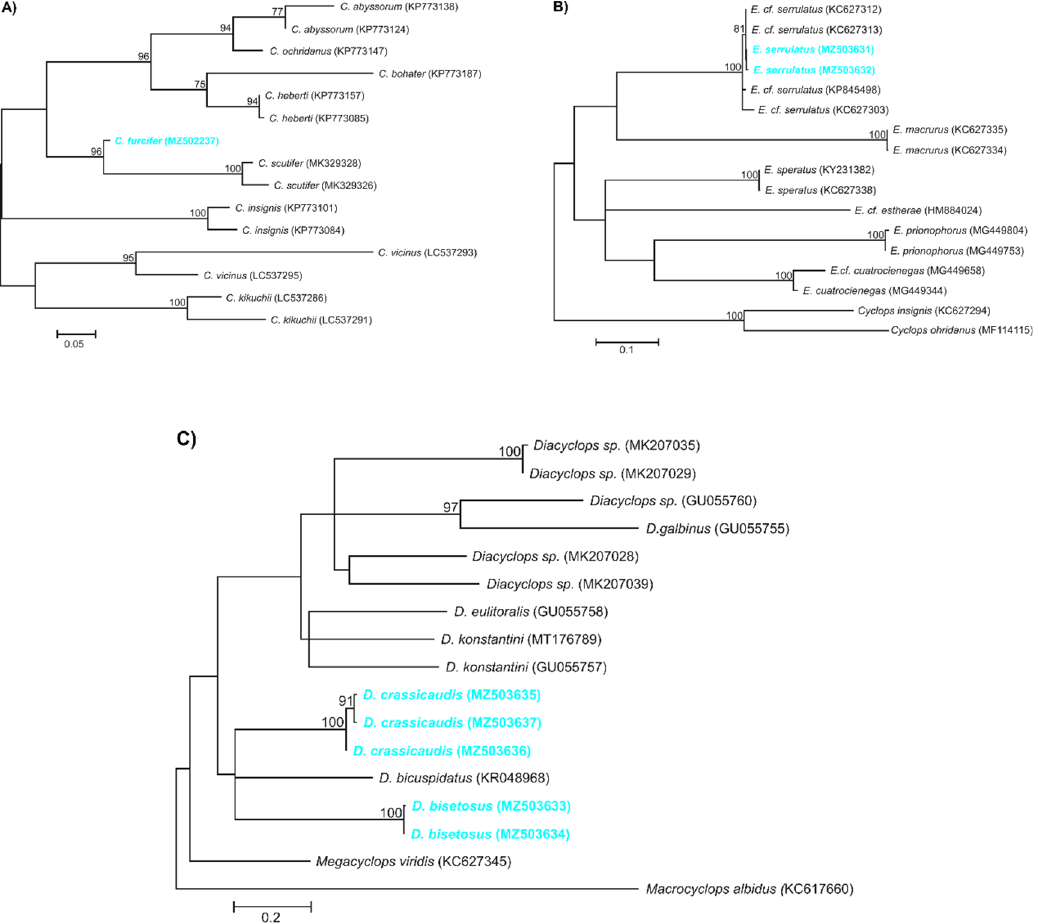
Figure 8. Maximum likelihood topology computed with the GTR+I+G model of substitution evolution, representing the phylogenetic relationships among the sequences of the 12S rRNA gene found in Cyclops furcifer ( A ), and the COI gene found in Eucyclops serrulatus ( B ), Diacyclops bisetosus and Diacyclops crassicaudis ( C ). Numbers listed at the nodes represent the percent support for the node from 1000 bootstrap replicates. The haplotypes found in this study are marked in blue and bolded.